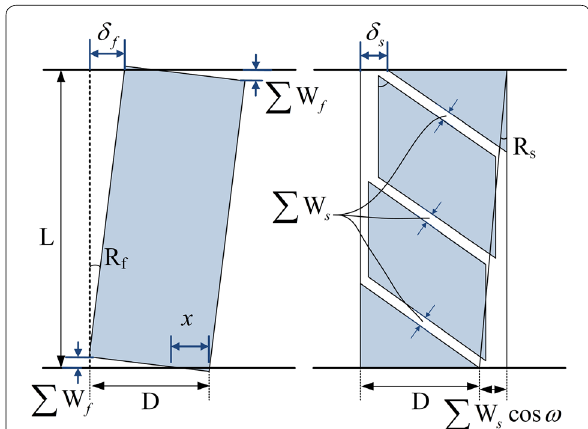
Fig. 2 Simplified crack‑deformation model of column (AIJ